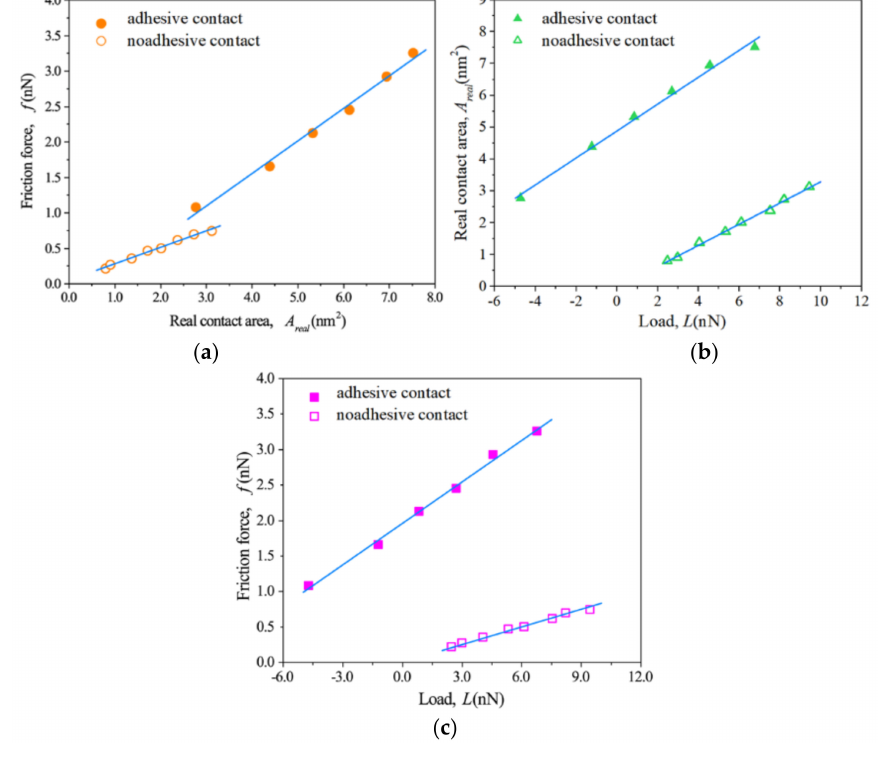
Figure 7. ( a ) Friction force versus real contact area, ( b ) real contact area versus normal load, ( c ) friction force versus normal load for the nanopatterned surface with l p = 2.17 nm and λ =